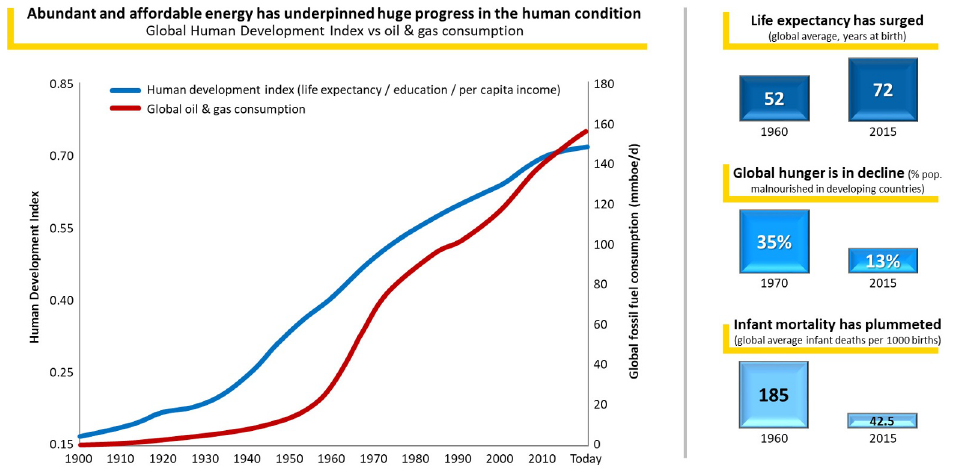
Fig. 13. – Global human development index vs. oil and gas consumption (from United Nations Development Programme and Eni